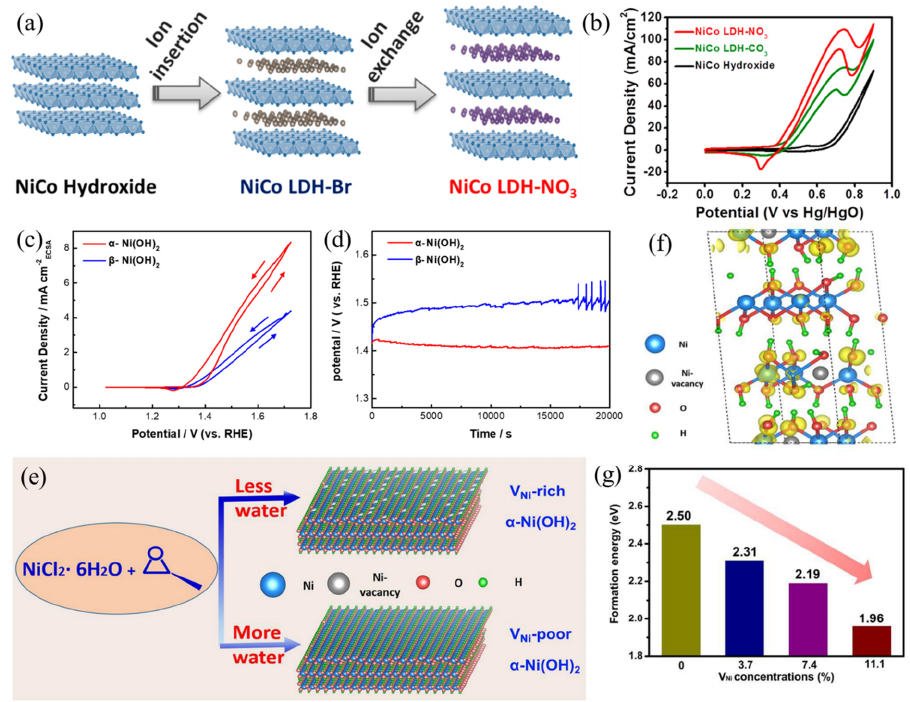
Figure 7. ( a ) Illustration of the synthetic process and ( b ) CV curves of NiCo LDH samples in 1 M KOH with 0.33 M urea; comparison of ( c ) CV curves and ( d ) stability tests of α - and β -Ni(OH) 2 in 1 M KOH with 0.33 M urea; ( e ) illustration of the preparation of Ni vacancies in α -Ni(OH) 2 ; ( f ) DFT simulation at the Fermi level induced by Ni vacancies and ( g ) the calculated formation energies acquired to form active γ− NiOOH; ( a , b , e – g ) Reprinted with permission from Refs. [46,48]. ( c , d ) Reprinted with permission from Ref. [47].